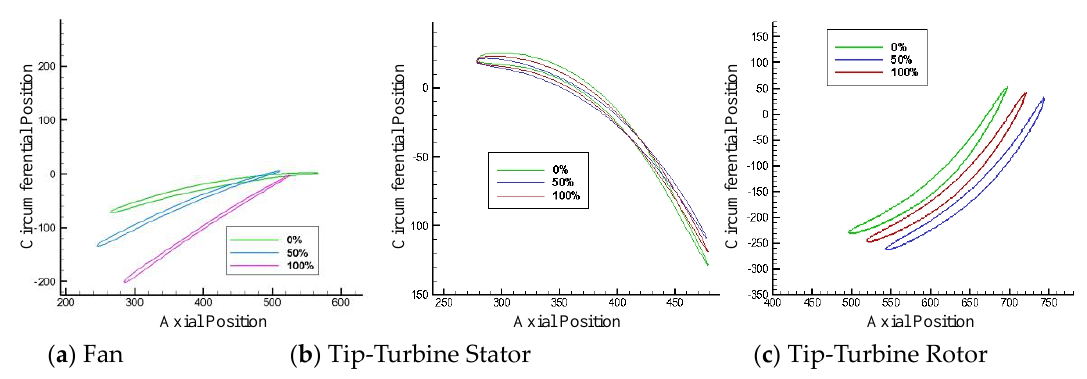
Figure 3. Section graphs of the ADFTT. (unit: mm; 0% represents the hub; 100% indicates the tip).